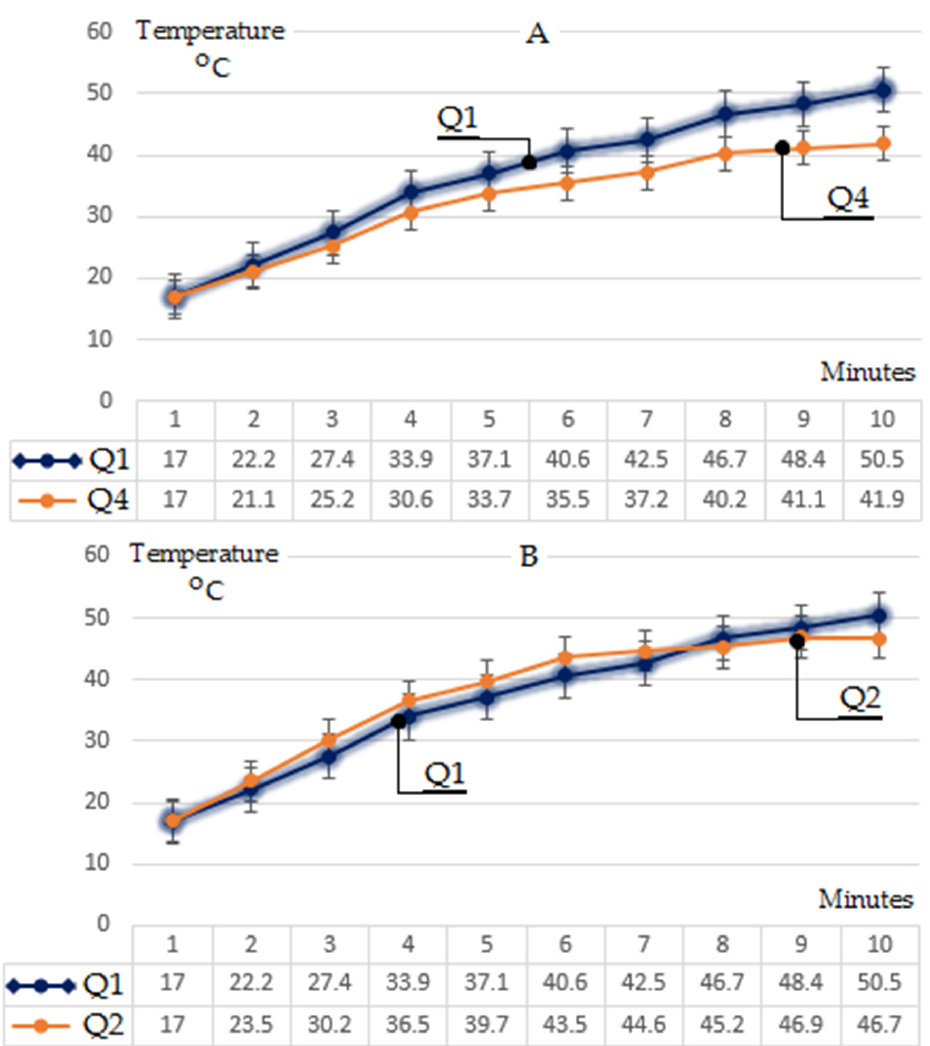
Figure 12. Transistors thermal difference for one melting cycle of 10 min. ( A ) Between transistors Q1 and Q4; ( B ) between transistors Q1 and Q2, both selected according to Figure 7A.